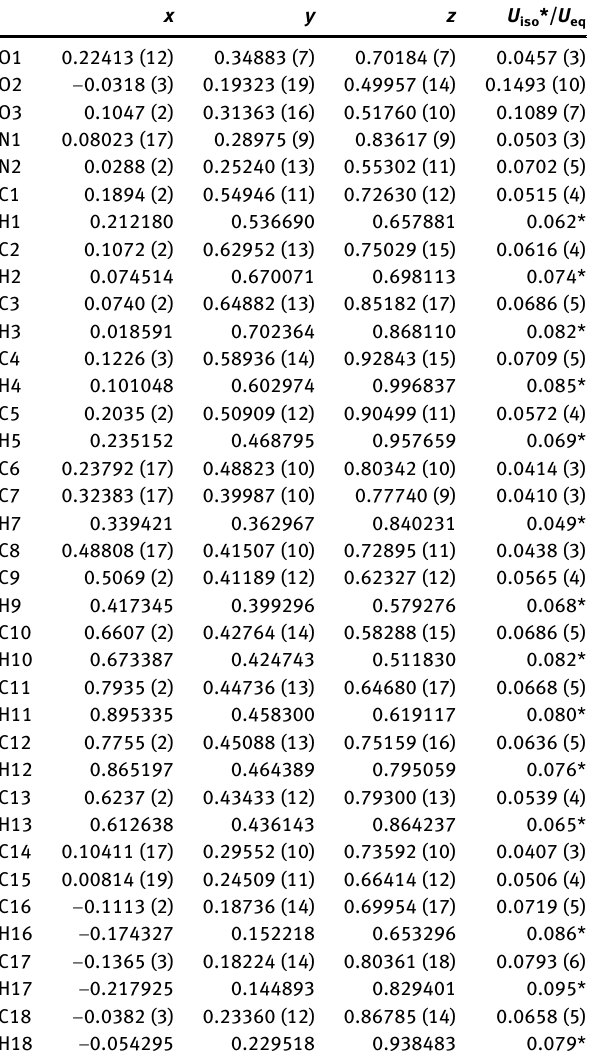
Table  : Fractional atomic coordinates and isotropic or equivalent isotropic displacement parameters (Å 